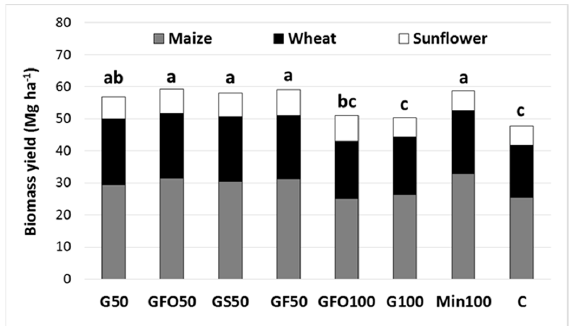
Figure 4. Cumulated biomass production (Mg ha − 1 ) over the entire crop succession. Different letters indicate significant differences, according to Tukey’s HSD test at p < 0.05. G50: 50% of N from G compost and 50% of N from mineral fertilization (MF). GFO50: 50% of N from G + F + O compost and 50% of N from MF. GS50: 50% of N from G + S compost and 50% of N from MF. GF50: 50% of N from G + F compost and 50% of N from MF. GFO100: 100% of N from G + F + O fertilization. G100: 100% of N from G compost. Min100: 100% of N from MF. C: Un-fertilized treatment.